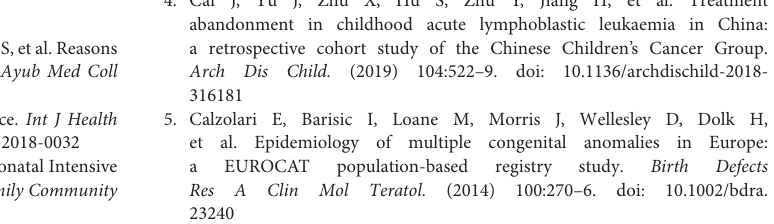
Supplementary Figure 1 | ROC curve analyses. Stratification values for (A) age at admission and (B) birth weight, which were calculated by ROC curve